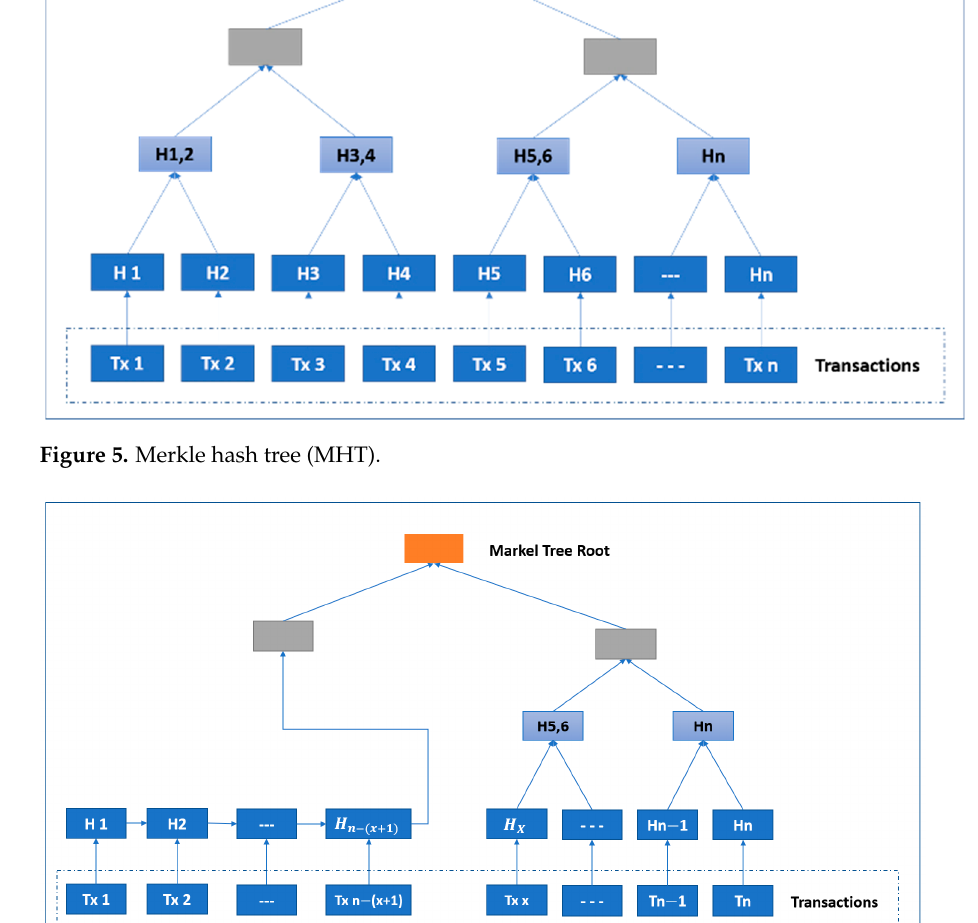
Table 1. Summary of local server specifications. Component